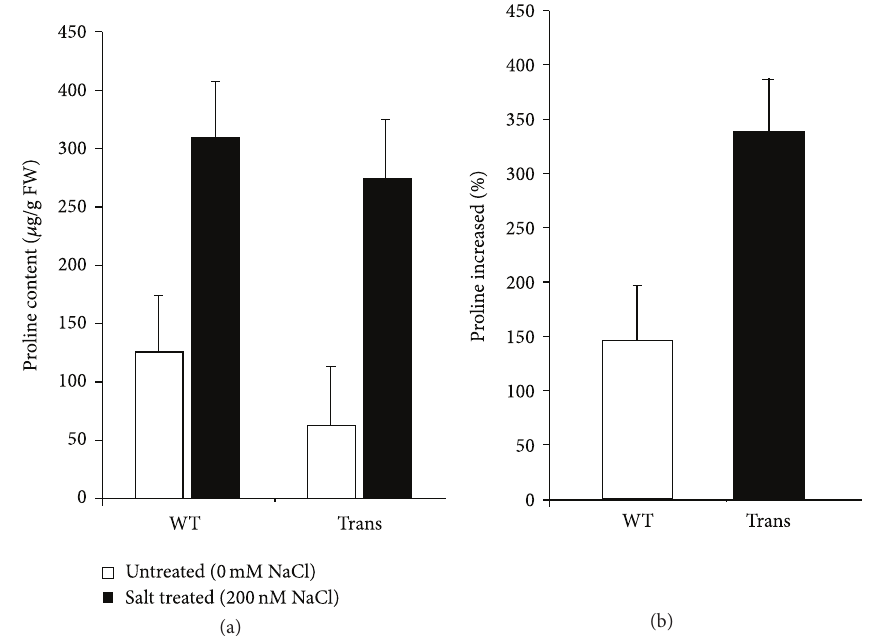
Figure 3: Overexpression of OsRab7 in rice increased the proline level under salt stress. (a) Level of proline in transgenic rice and WT rice under normal conditions and salt treatment. (b) Increasing rate of proline production after salt stress between the transgenic and WT rice. These data are the averages of triplicate assays and the error bars indicate the SDs.